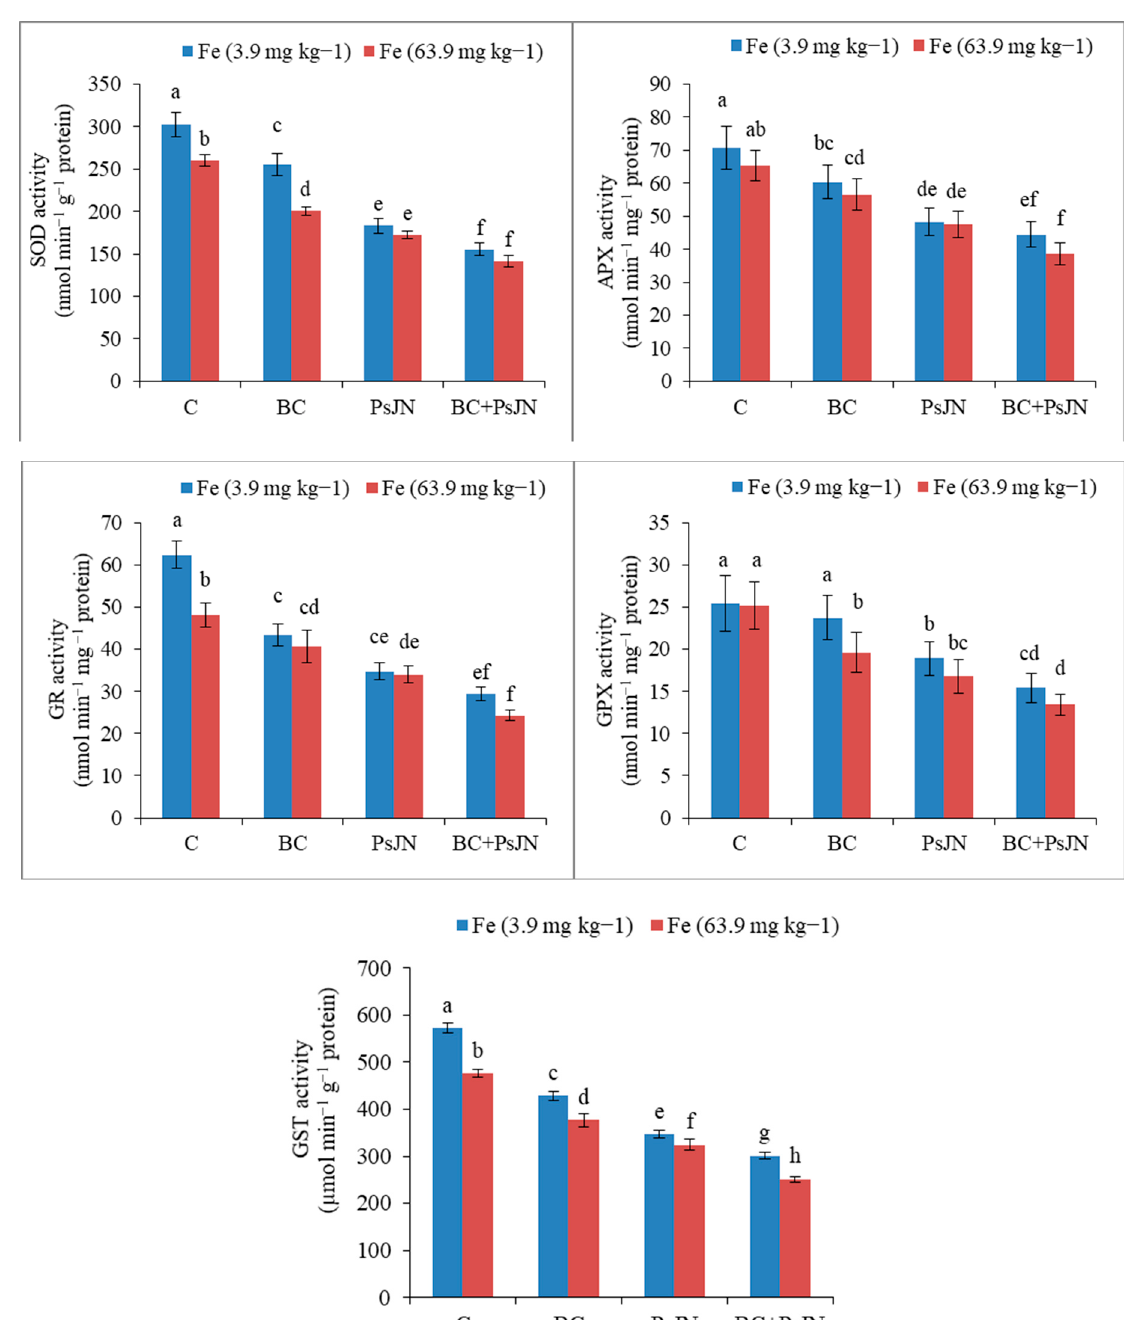
Figure 4. The effect of biochar- Burkholderia phytofirmans PsJN integration on antioxidant activity of Chenopodium quinoa under salinity stress. SOD = Super-oxide dismutase, APX = Ascorbate peroxidase, GR = Glutathione reductase, GPX = Glutathione peroxidase, GST = Glutathione S-transferase. Quantities sharing similar letters are not different with each other. C: Control; BC: Biochar (1% w / w ); PsJN: Burkholderia phytofirmans ; Fe: Ferrous sulphate (15 kg ha − 1 ). Values are mean of three repeats ± SD.